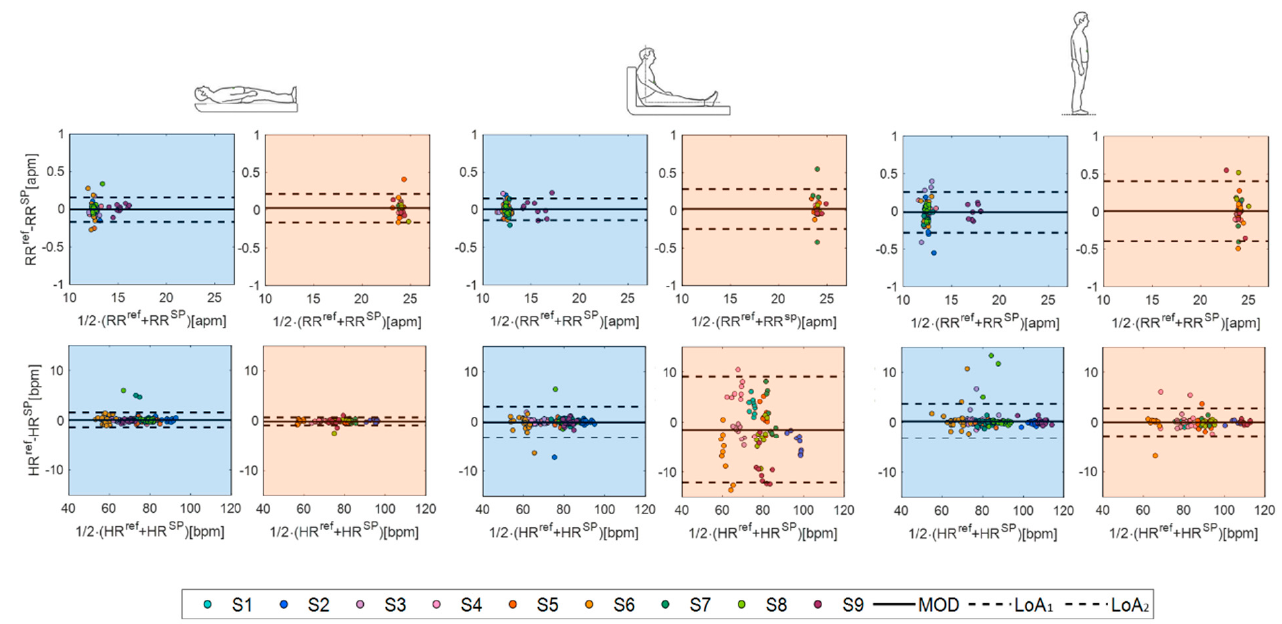
Figure 12. Bland–Altman plots: MOD (black line) and LOAs (black dotted lines) in eupnea (light blue backgrounds) and tachypnea (light orange backgrounds) in supine, sitting, and standing positions.